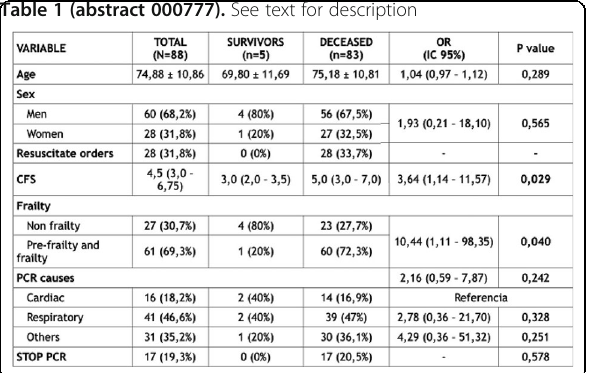
Table 1 (abstract 000777). See text for